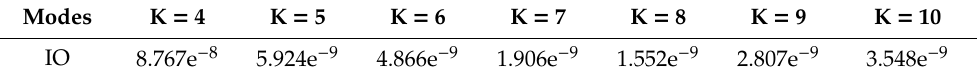
Figure 26. The decomposed modes of VMD-HT algorithm. (mode1: DC value 620 V, mode 2: 50 Hz, mode 3:100 Hz, mode 4: 150 Hz, mode 5:200 Hz, mode 6:250 Hz, mode 7: 300 Hz, mode 8: 350 Hz).